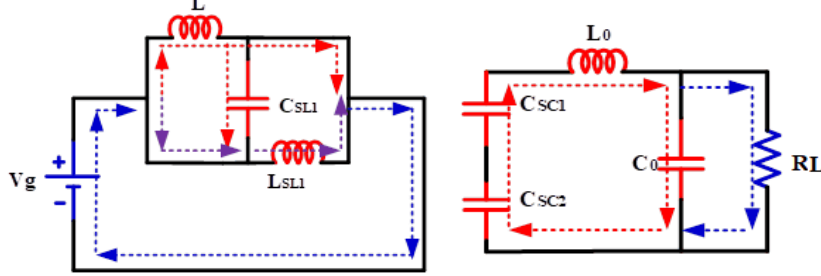
Figure 4. Current flow path of the converter circuit during the interval t on .